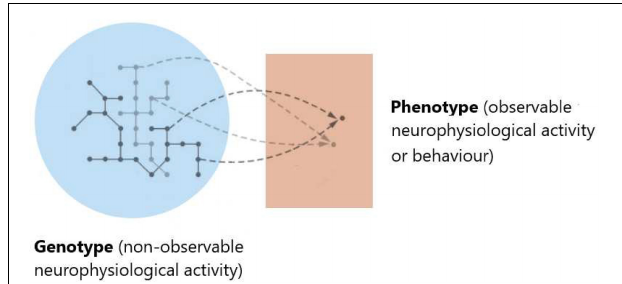
FIGURE 2 | Gauging the functional space. Evaluating the significance of brain activity may require comparing data from different experimental conditions or subjects. This may involve not only asking whether given data sets are distinguishable, and quantifying how far apart they are but also establishing which configurations can be attained from given ones. Rather than the similarity of neuroimaging data representations, a dynamical definition of nearness and neighborhood should reflect the structure induced by the accessibility of given states induced by physiological process dynamics. This notion can be understood by thinking of (cid:56) NObs as genotype , and (cid:56) Obs (or observed behavior) as the corresponding phenotype . Characterizing accessibility in the phenotype space means understanding which phenotypic variations (corresponding to genuine functional differences) are realizable and which dynamical changes or image representation differences (depicted by networks of different gray shades in the genotype space) are functionally neutral, i.e., have equivalent function, with respect to underlying neurophysiological